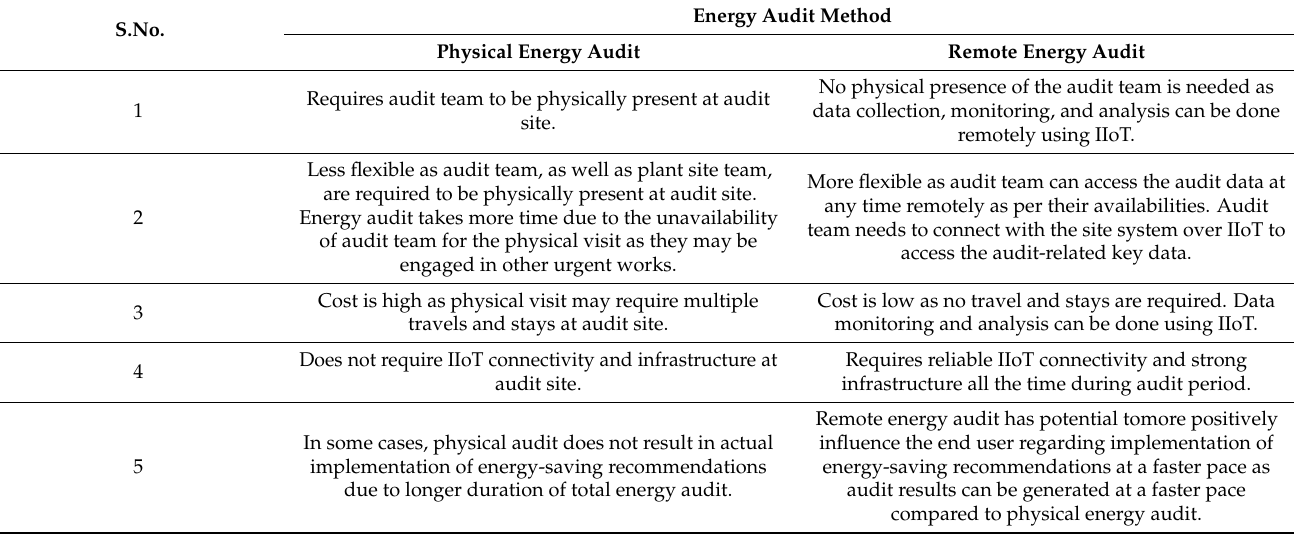
Table 6. Comparison of a physical energy audit with remote energy audit